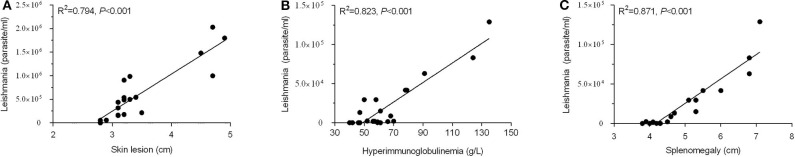
Correlation of parasite load detected by qPCR with severity of leishmaniasis. (A) Parasite load correlated with skin lesion diameter of CL. (B) Parasite load correlated with levels of serological immunoglobulin in VL. (C) Parasite load correlated with splenomegaly tested by ultrasonography in VL.